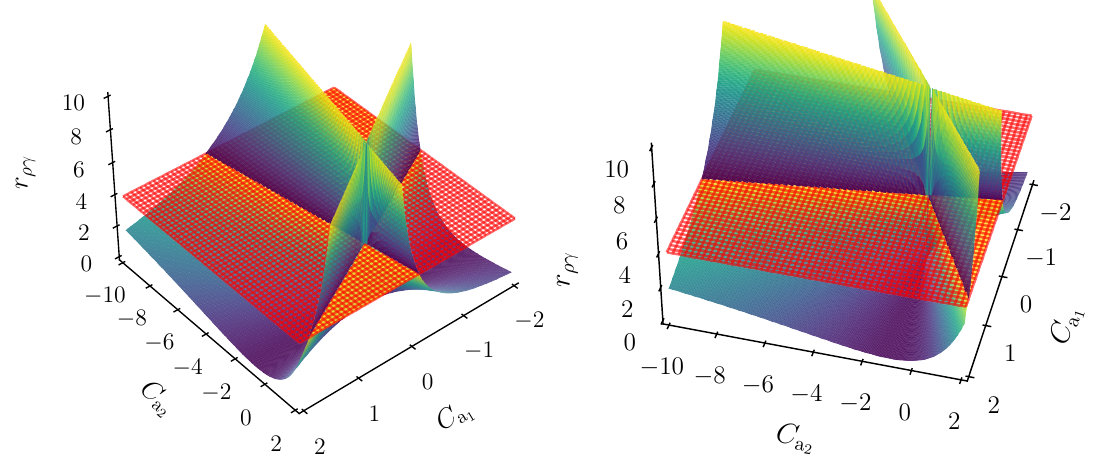
Figure 8 . Surface plots of r ργ ( blue-yellow textured ), equation (4.34), using the central value of C s = 0 . 93(11) , equation (4.24), together with the central value of the measurement r ργ = 3 . 9(1 . 3) [87] ( red ) from two different perspectives ( left and right